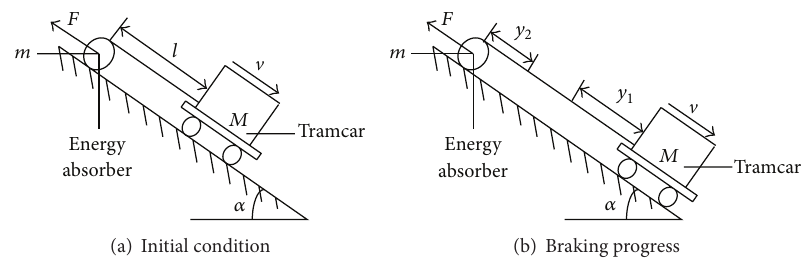
Figure 4: Displacement of braking wire.